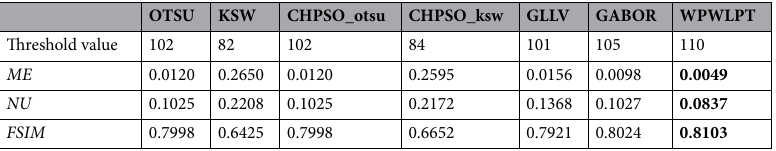
Table 1. The threshold values, MEs , NUs and FSIMs of the seven thresholding methods on the synthetic “Circles” image. The best results are highlighted in bold.